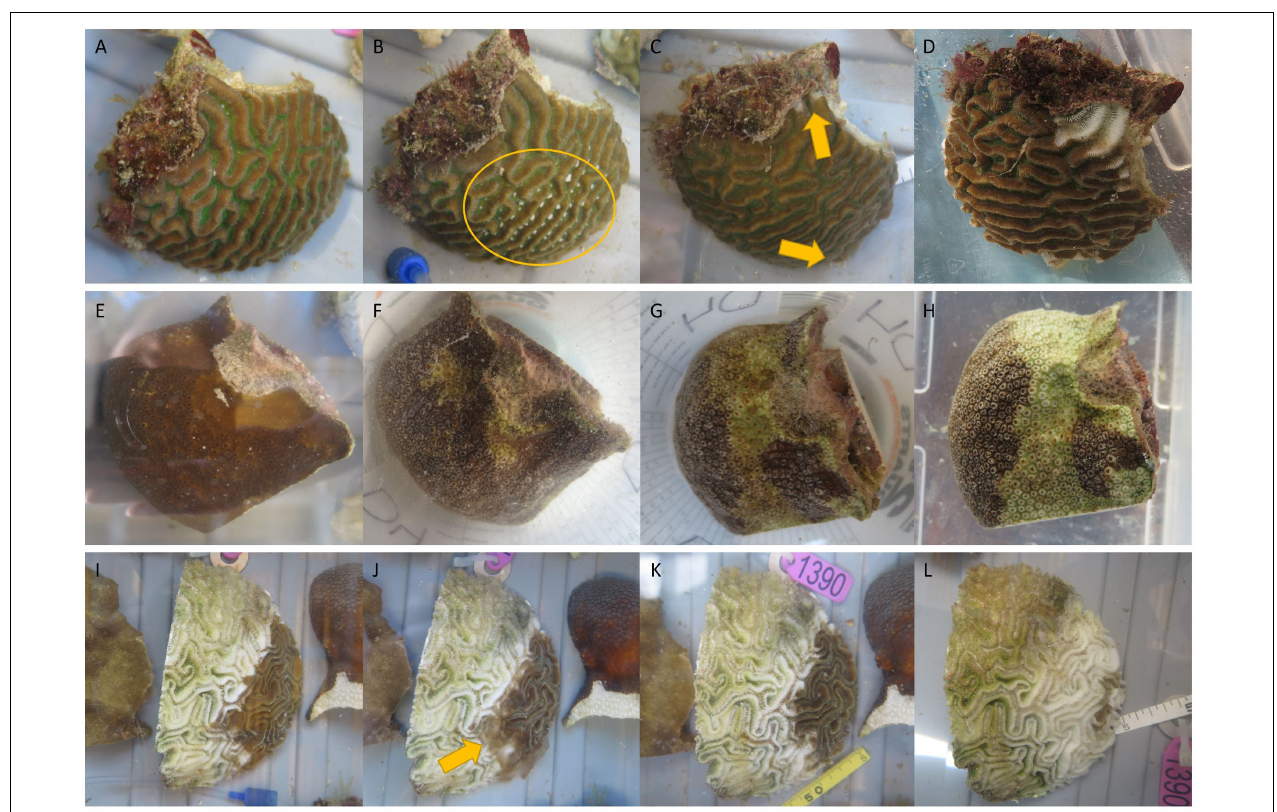
FIGURE 2 | Rapid expansion of lesions on a Pseudodiploria strigosa fragment (A–D) and an Orbicella annularis fragment (E–H) exposed to stony coral tissue loss disease (SCTLD; exemplified by the central colony of diseased Diploria labyrinthiformis in I–L ). (A) Day 0, fragment is visually healthy. (B) Day 4, fragment has mesentery filaments extended suggesting signs of stress (yellow circle). (C) Day 5, fragment develops tissue loss (yellow arrows). (D) Day 6, both lesions progressed. (E) Day 0, fragment is visually healthy. (F) Day 1, fragment is partially bleached and develops tissue loss. (G) Day 2 morning, lesion progressed and bleaching area has increased. (H) Day 2 afternoon, lesion progressed and bleaching area has increased. (I) Day 1, colony has signs of rapid tissue loss suspected to be SCTLD. (J) Day 2 morning pre-water change, lesion has progressed and sloughed tissue resides immediately above the skeleton (yellow arrow). (K) Day 2